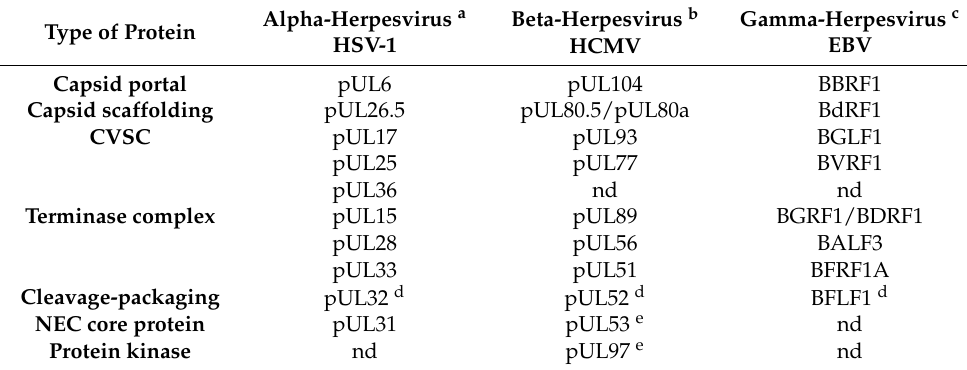
Table 1. Herpesviral nuclear capsid-associated